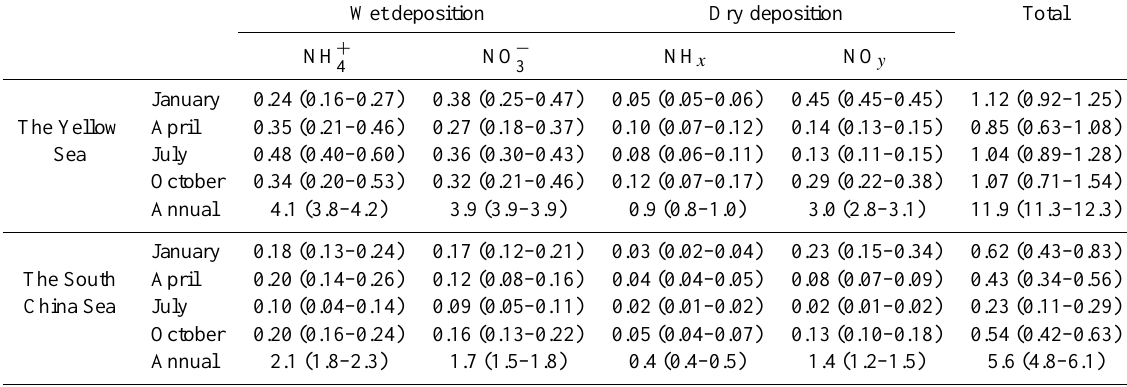
Figure 7. GEOS-Chem simulated monthly nitrogen deposition fluxes to the northwestern Pacific in January, April, July and October 2008– 2010. The black boxes in the left panel represent areas of the Yellow Sea and the South China Sea used in the adjoint analyses. Table 3. Monthly and annual nitrogen deposition fluxes to the Yellow Sea and the South China Sea for 2008–2010 ∗ . Wet